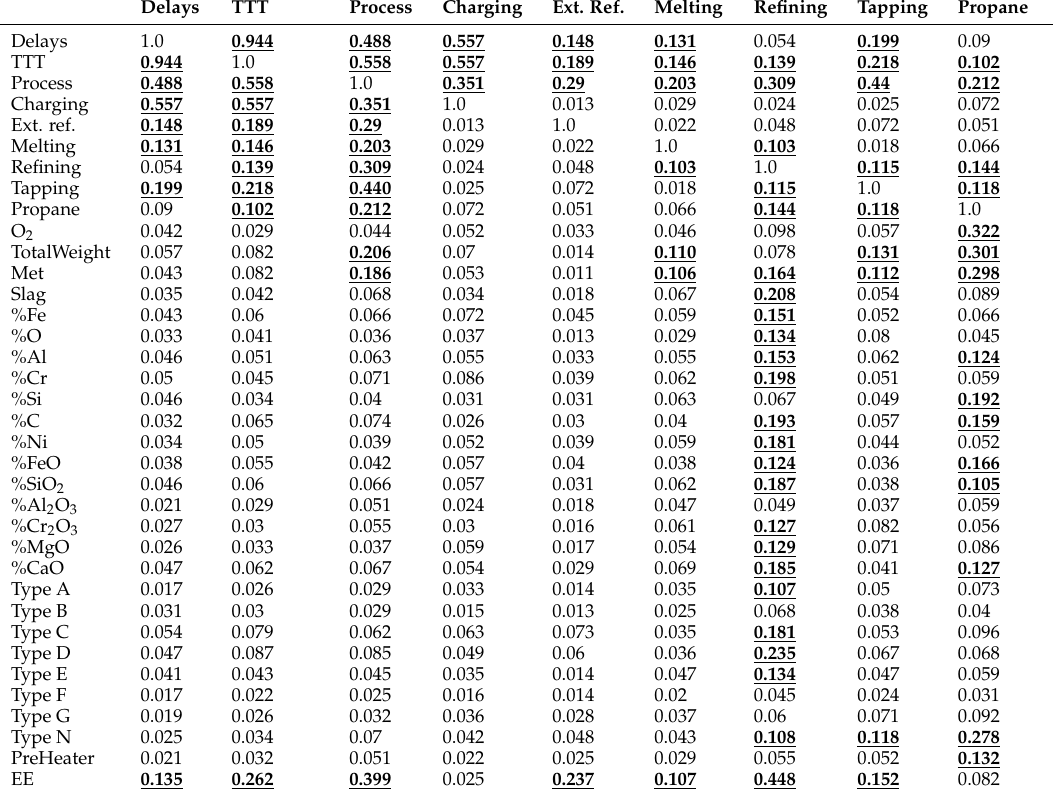
Table A4. Variable-variable dCor for the training data. dCor values at ± 0.1, or above, is bold and underlined. Delays TTT Process Charging Ext. Ref. Melting Refining Tapping